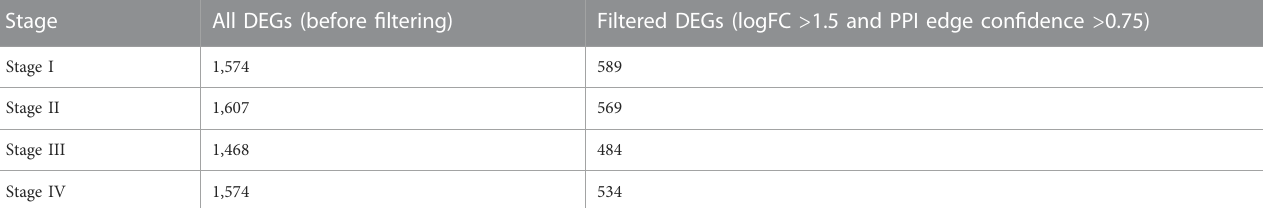
TABLE 2 Filtered DEGs. Stage All DEGs (before fi ltering)